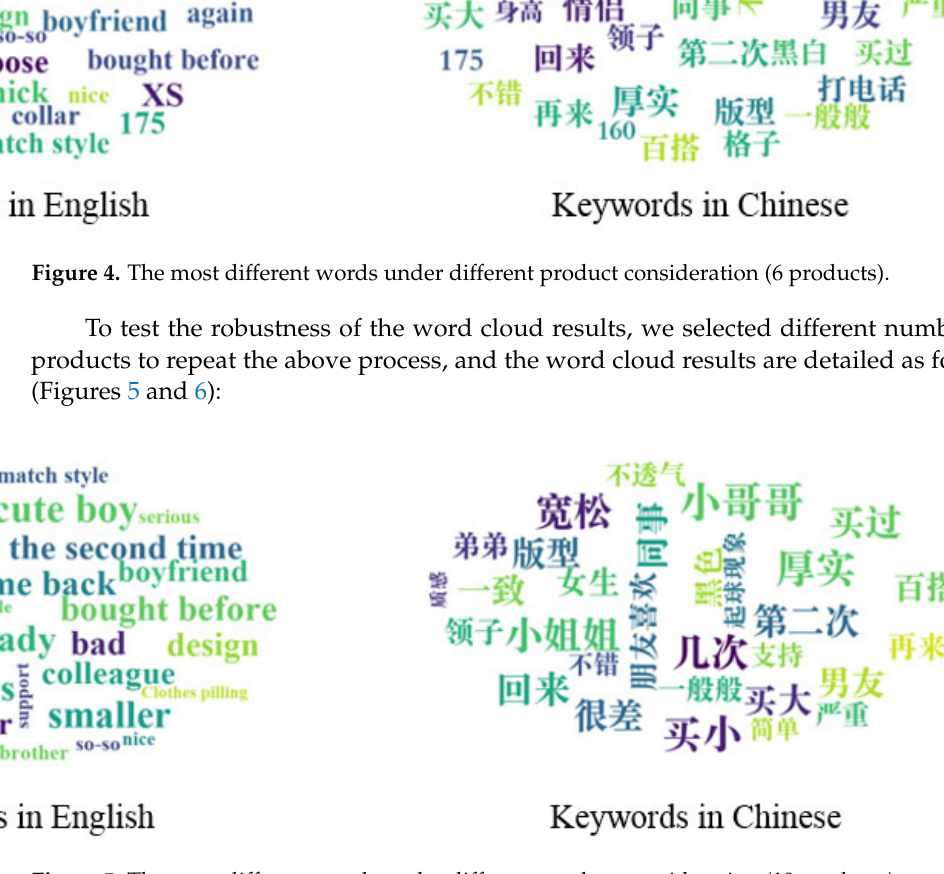
Figure 6. The most different words under different product consideration (16 products).